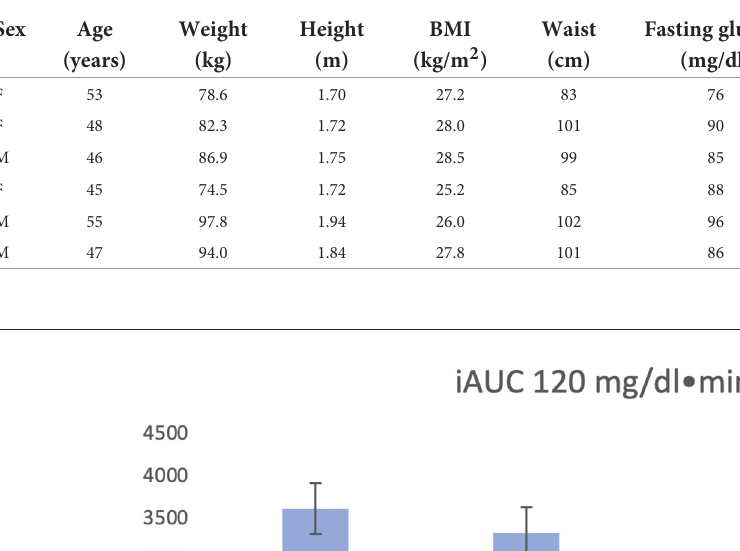
Diabetes Association for subcutaneous glucose